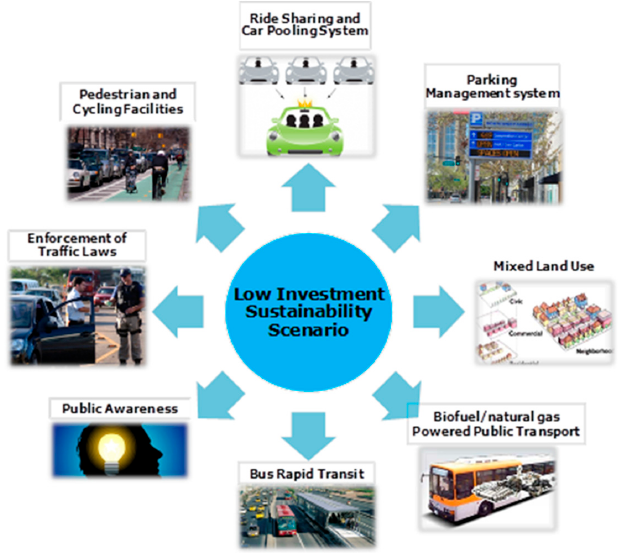
Figure 7. General description of the LIS scenario [27].